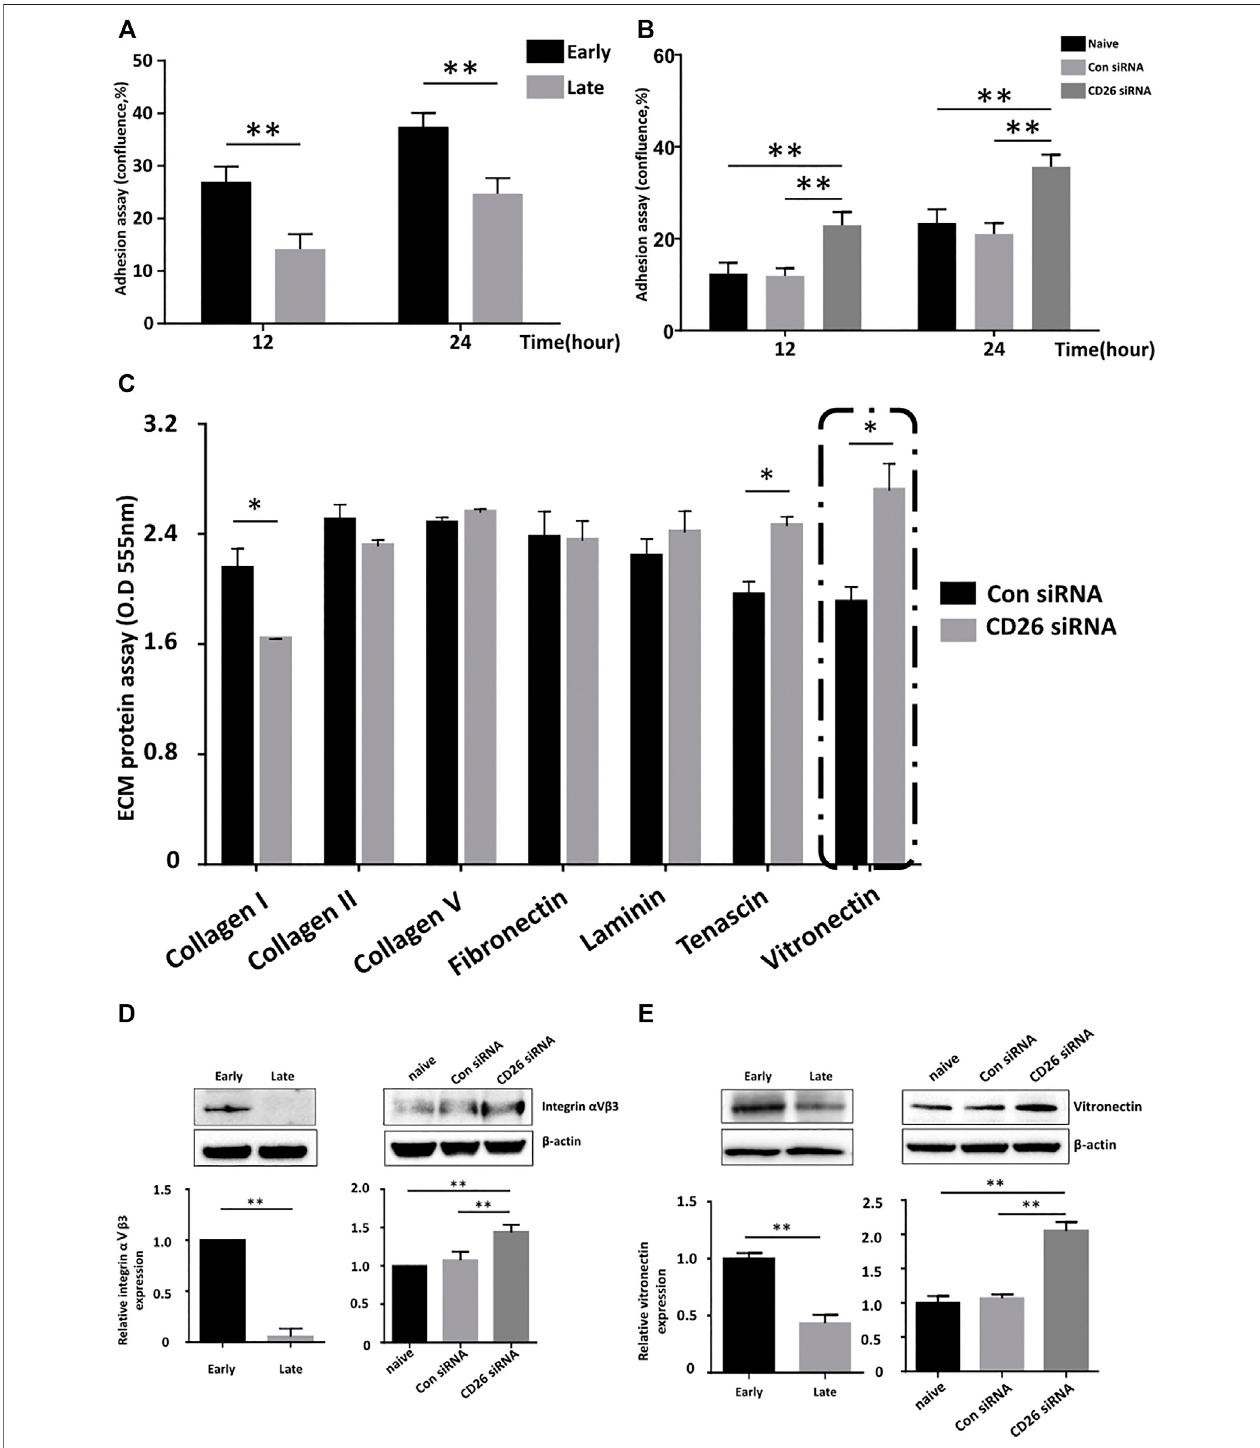
FIGURE 3 | Knockdown of CD26 in hUCB-MSCs improves their attachment to the extracellular matrix. (A) Time-dependent changes in the con fl uence of early (passage 4) and late (passage 10) passage hUCB-MSCs ( n (cid:1) 3). (B) Time-dependent change in the con fl uence of scrambled control- or CD26 siRNA- treated hUCB-MSCs ( n (cid:1) 3). (C) Extracellular matrix cell adhesion array analyses of scrambled control- or CD26 siRNA-treated hUCB-MSCs ( n (cid:1) 3). (D, E) Immunoblotting images and densitometry of Integrin α Ⅴ β 3 (D) and vitronectin (E) in early (passage 4) and late (passage 10) hUCB-MSCs (left) or hUCB- MSCs transfected with scrambled control or CD26 siRNA (right) ( n (cid:1) 3, passage 6). Abbreviation: hUCB-MSCs, human umbilical cord blood mesenchymal stem cells; siRNA, small interfering RNA. * p < 0.05; ** p < 0.01.